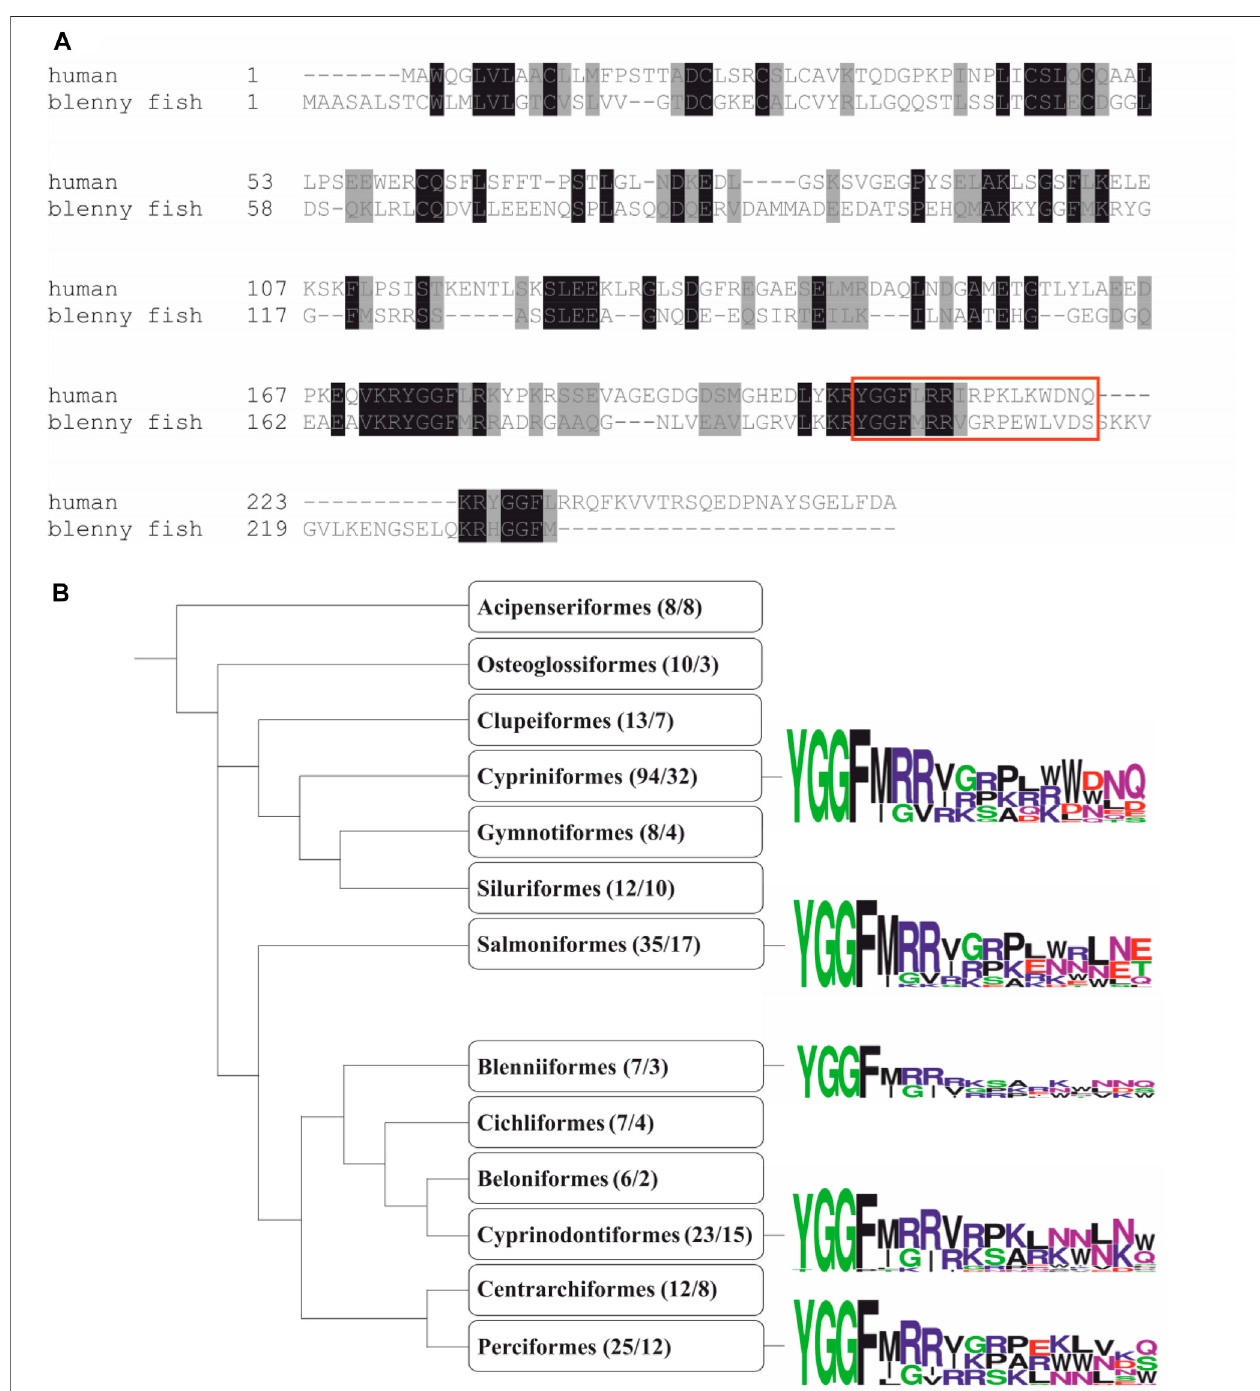
FIGURE 1 | Genome mining. (A) Comparison of the human preprodynorphin precursor (Sequence ID: P01213 and the novel precursor identi fi ed in the blenny fi sh M. atrodorsalis . The identi fi ed hit (Sequence ID: P0DP56.1) contains the YGGF motif typical for human opioid peptides. FASTA sequences were aligned by Clustal Omega and are shown in box-shade format. Identical and similar amino acid residues are highlighted in black and grey, respectively. Mature human dyn A 1 – 17 and blenny fi sh dyn A 1 – 17-like peptide are indicated by the red box. (B) A schematic phylogenetic tree based on the taxonomic pro fi le of fi sh as described by Hughes etal.(2018)isillustrated.Onlytaxawithmorethan fi vehitsareshown.Thenumbersofuniquehitspertaxonomicgroupandthenumberofavailabletranscriptomesinthis group are displayed in brackets, separated by a forward slash, respectively. Sequence logos of hits were generated with WebLogo for the taxa Cypriniformes, Salmoniformes, Cyprinodontiformes, and Perciformes. They are shown as representative examples in comparison to Blenniiformes.